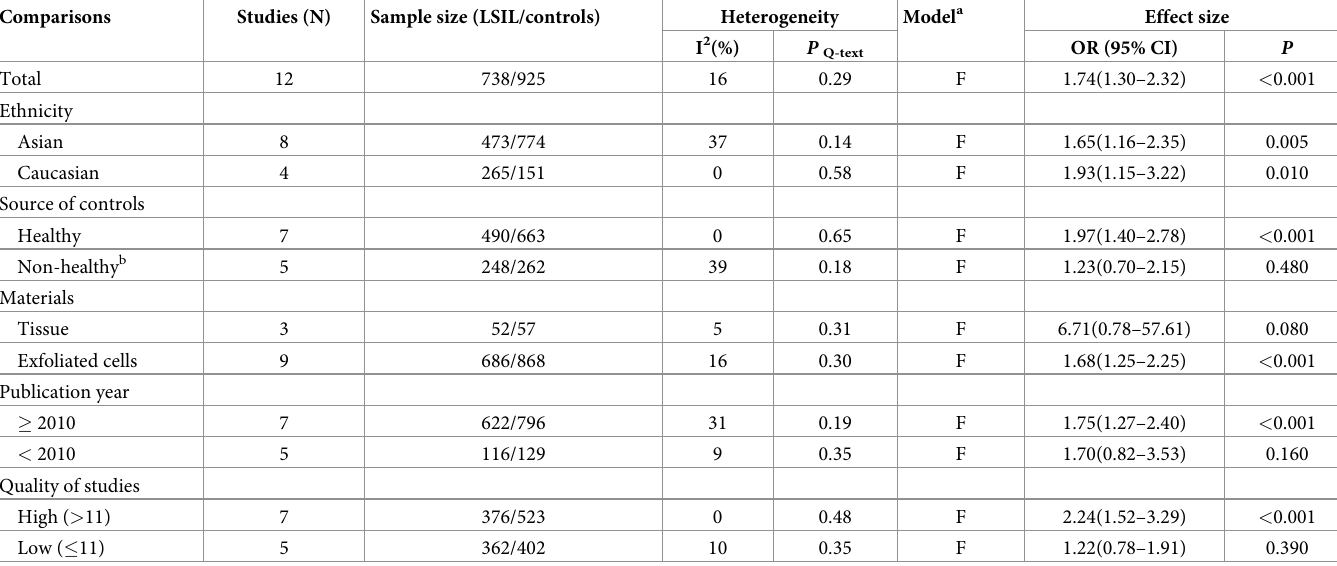
Table 3. Pooled results for the association of MGMT promoter hypermethylation with LSIL